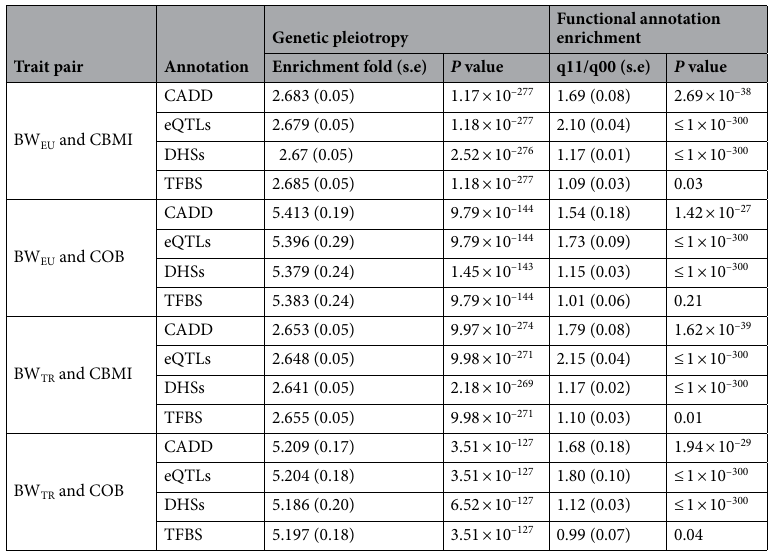
Table 1. Genetic pleiotropy and enrichment of functional deleteriousness among genetic loci associated with birth weight and childhood obesity traits. q 11/ q 00 is the ratio of the probability of jointly associated SNPs being functionally annotated to the probability of a null SNP (not associated with either trait) being functionally annotated. BW EU and CBMI European birth weight and childhood body mass index, BW EU and COB European birth weight and childhood obesity, BW TR and CBMI trans-ethnic birth weight and childhood body mass index, BW TR and COB trans-ethnic birth weight and childhood obesity, CADD combined annotation dependent depletion, eQTLs expression quantitative loci, DHSs DNase I hypersensitivity sites, TFBS transcription factor binding